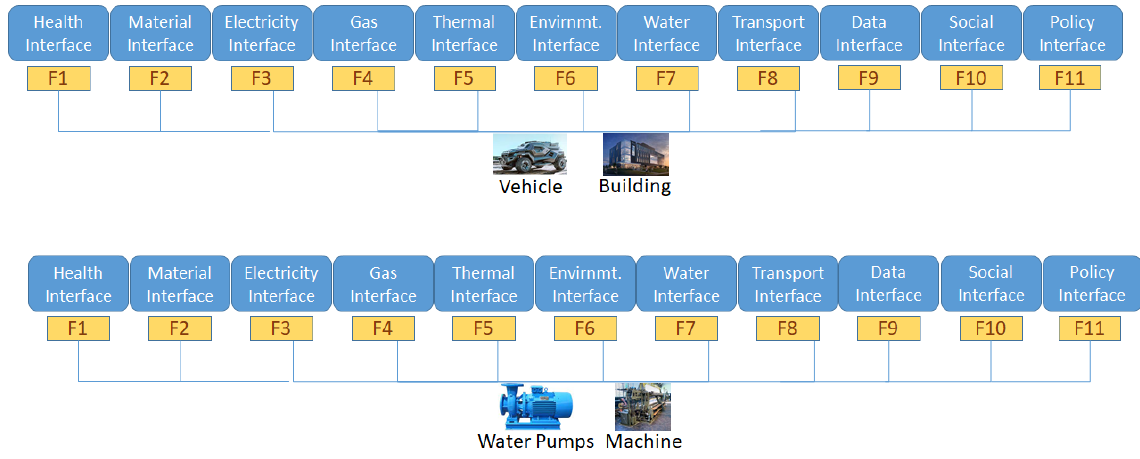
Figure 11. Interface system design and unified function mapping.